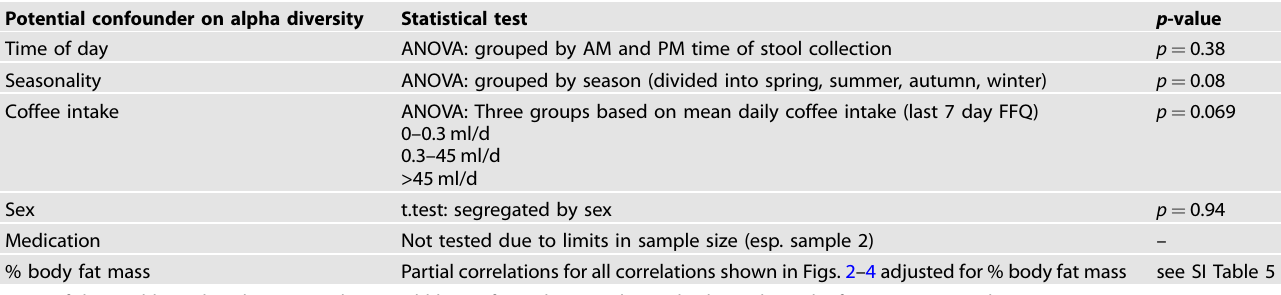
Table 3. Potential confounders on gut microbiome